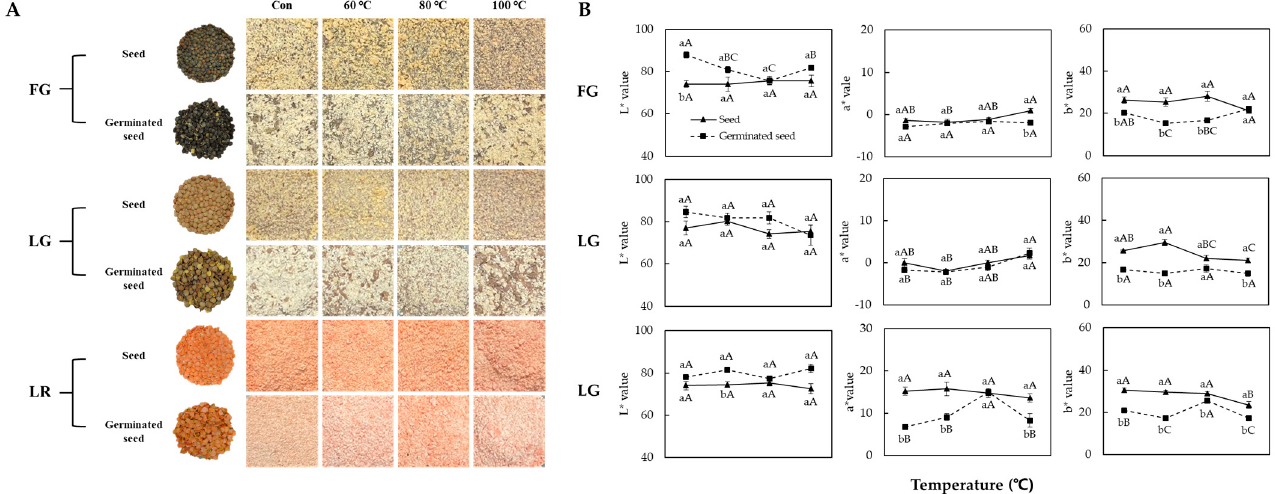
Figure 1. Seed morphology and powder color ( A ) of seed (nongerminated seed, NGS) and germinated seed (GS) in lentils (FG, LG, and LR) and CIE − color change of the powder ( B ) during thermal processing. Different lowercase letters indicate the significant differences (Tukey’s studentized test at p < 0.05) between NGS and GS, and capital letters indicates the significant differences (Tukey’s studentized test at p < 0.05) between lentil cultivars treated with different temperatures.